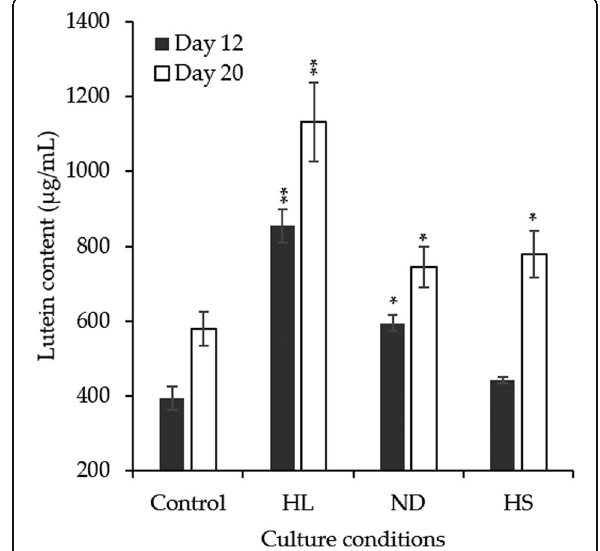
Fig. 4 β -carotene content of D. salina Y6 under the tested abiotic- stress conditions. HL, high-light conditions; ND, nitrogen-depleted conditions; HS, high-salt conditions. ** p < 0.01, * p < 0.05. The values represent mean ± S.D. ( n = 3)